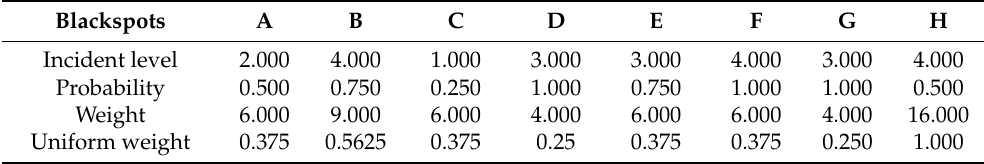
Table 1. Blackspot weights.